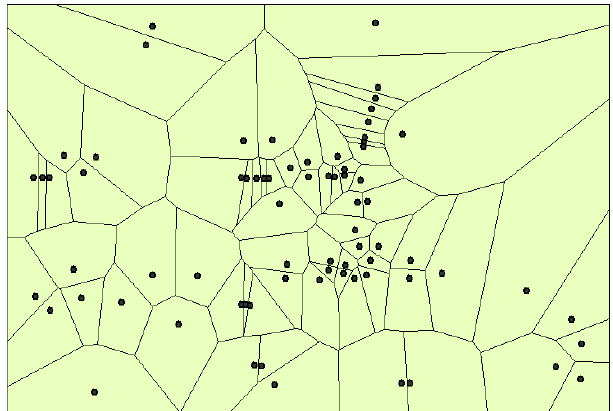
Figure 5. Voronoi polygons of points.